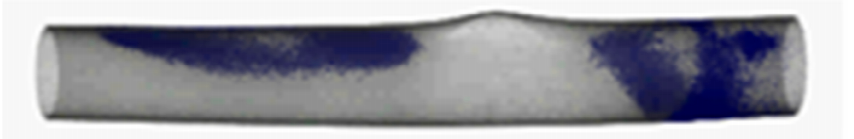
Figure 2. Hydrogen distribution in the cladding around the burst opening of rod #04 of the QUENCH-L3 test (the positions containing hydrogen are marked with blue color).